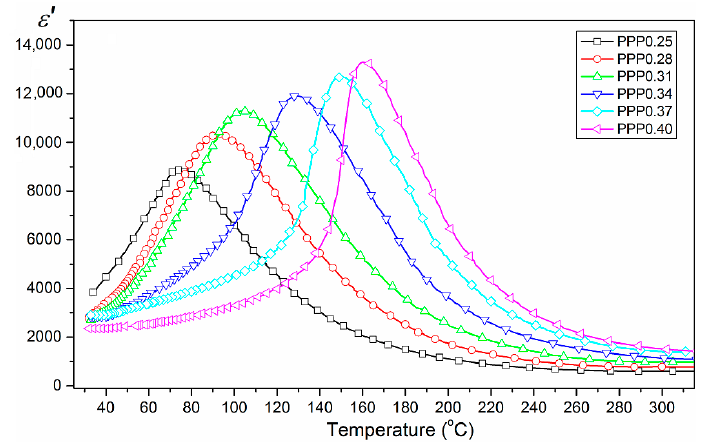
Figure 5. Dependencies ε ’ ( T ) for PMN–PT–PS ceramics (cooling cycle for 1 kHz).